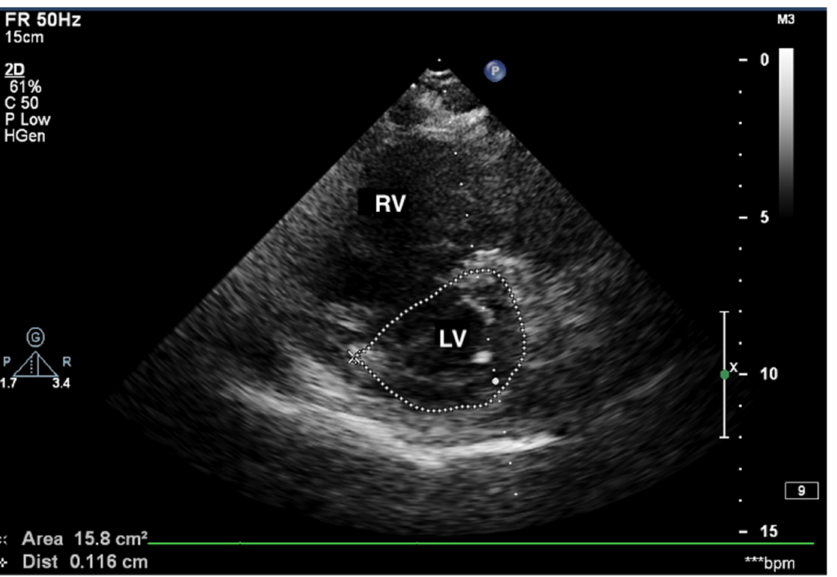
Figure 5. D-sign, enlarged right ventricle, ventricular septum displaced towards LV. 2D-TTE, short- axis view (SAX). LV: left ventricle; 2D-TTE: two-dimensional transthoracic